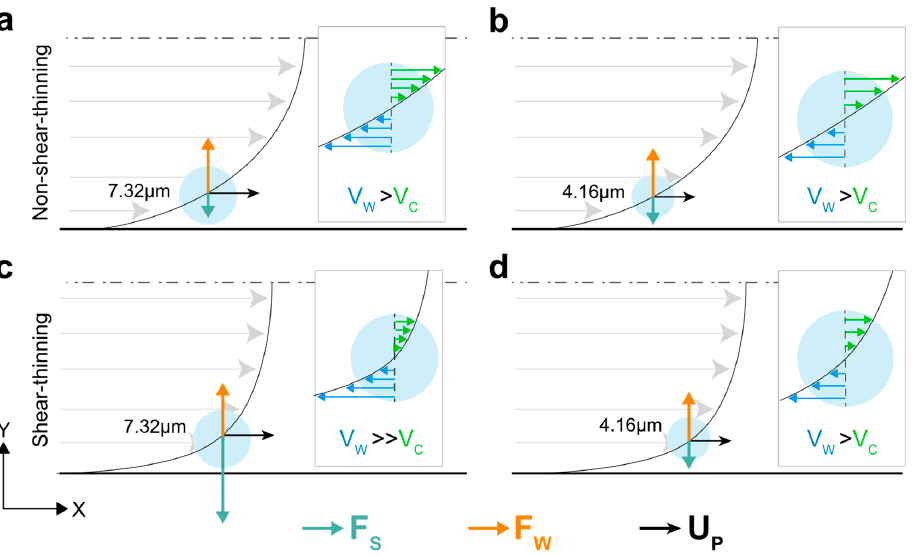
Figure 11. Schematics of the effect of shear-thinning behavior of the fluid on the inertial force near the channel walls. Both ( a ) 7.32 µ m and ( b ) 4.16 µ m diameter particles experience positive net inertial force (F W > F S ) in non-shear-thinning fluids. ( c ) Shear-thinning promotes the shear-gradient lift force (Fs) by imposing stronger relative velocity imbalance on the particle surface for the 7.32 µ m particles, causing net inertial force to be negative near the channel walls. ( d ) The 4.16 µ m diameter particles are not large enough to capture this relative velocity